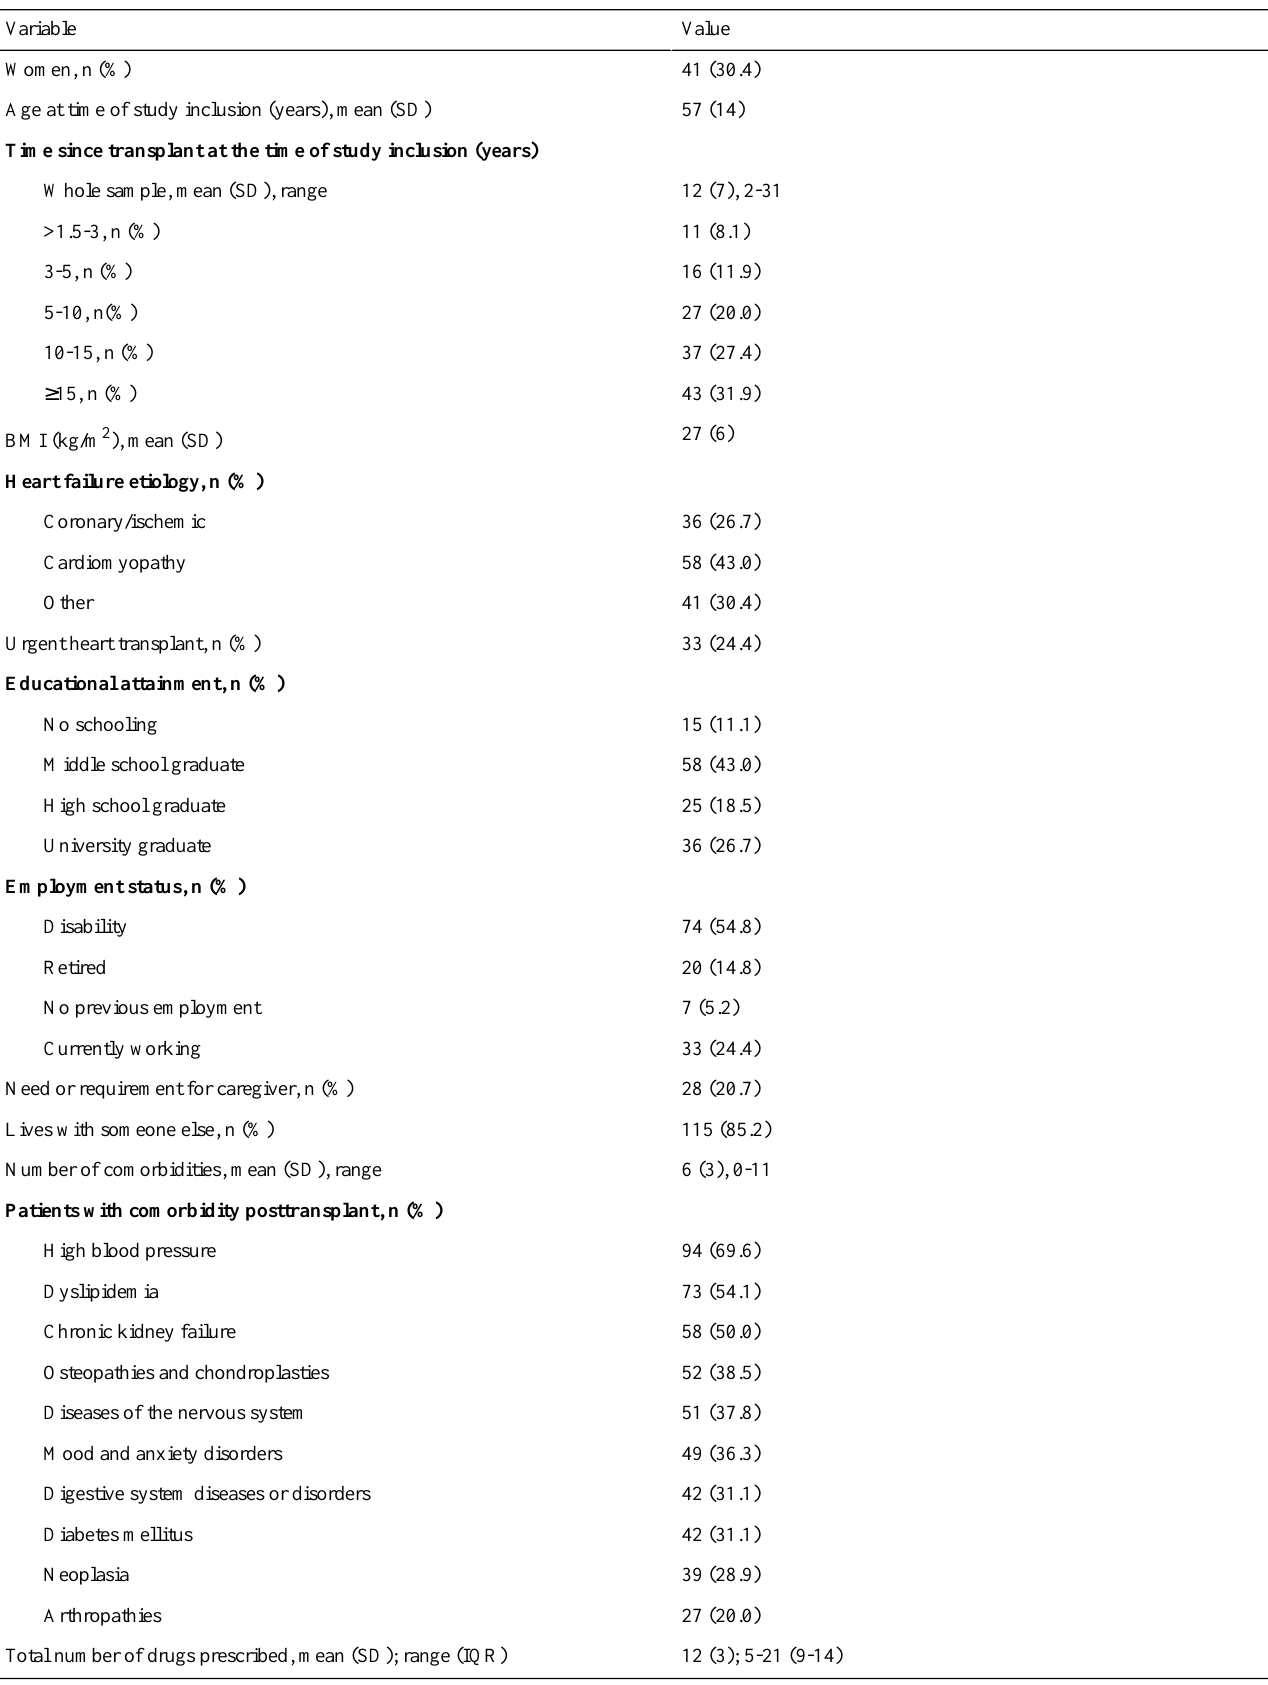
Table 1. Chronic heart transplant recipients’(>1.5 years from transplant) sociodemographic and clinical characteristics